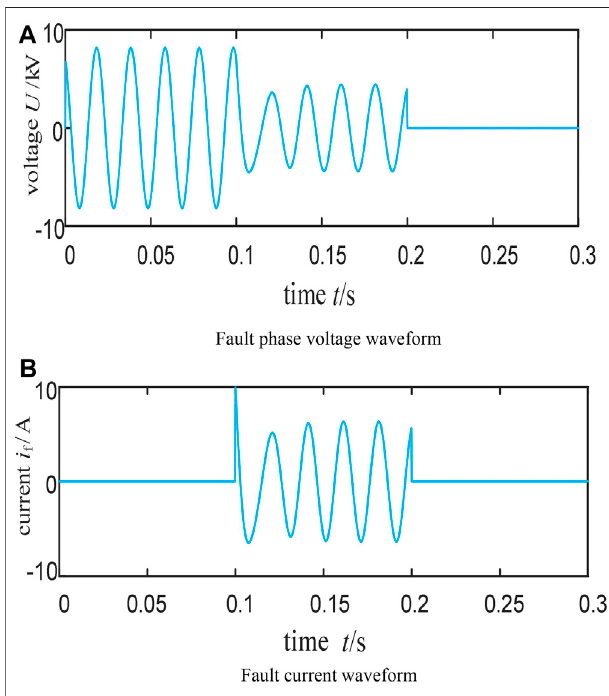
FIGURE 11 | Waveforms of the fault voltage and current when tap position is at initial tap position plus 1. (A) Fault phase voltage waveform (B) Fault current waveform.